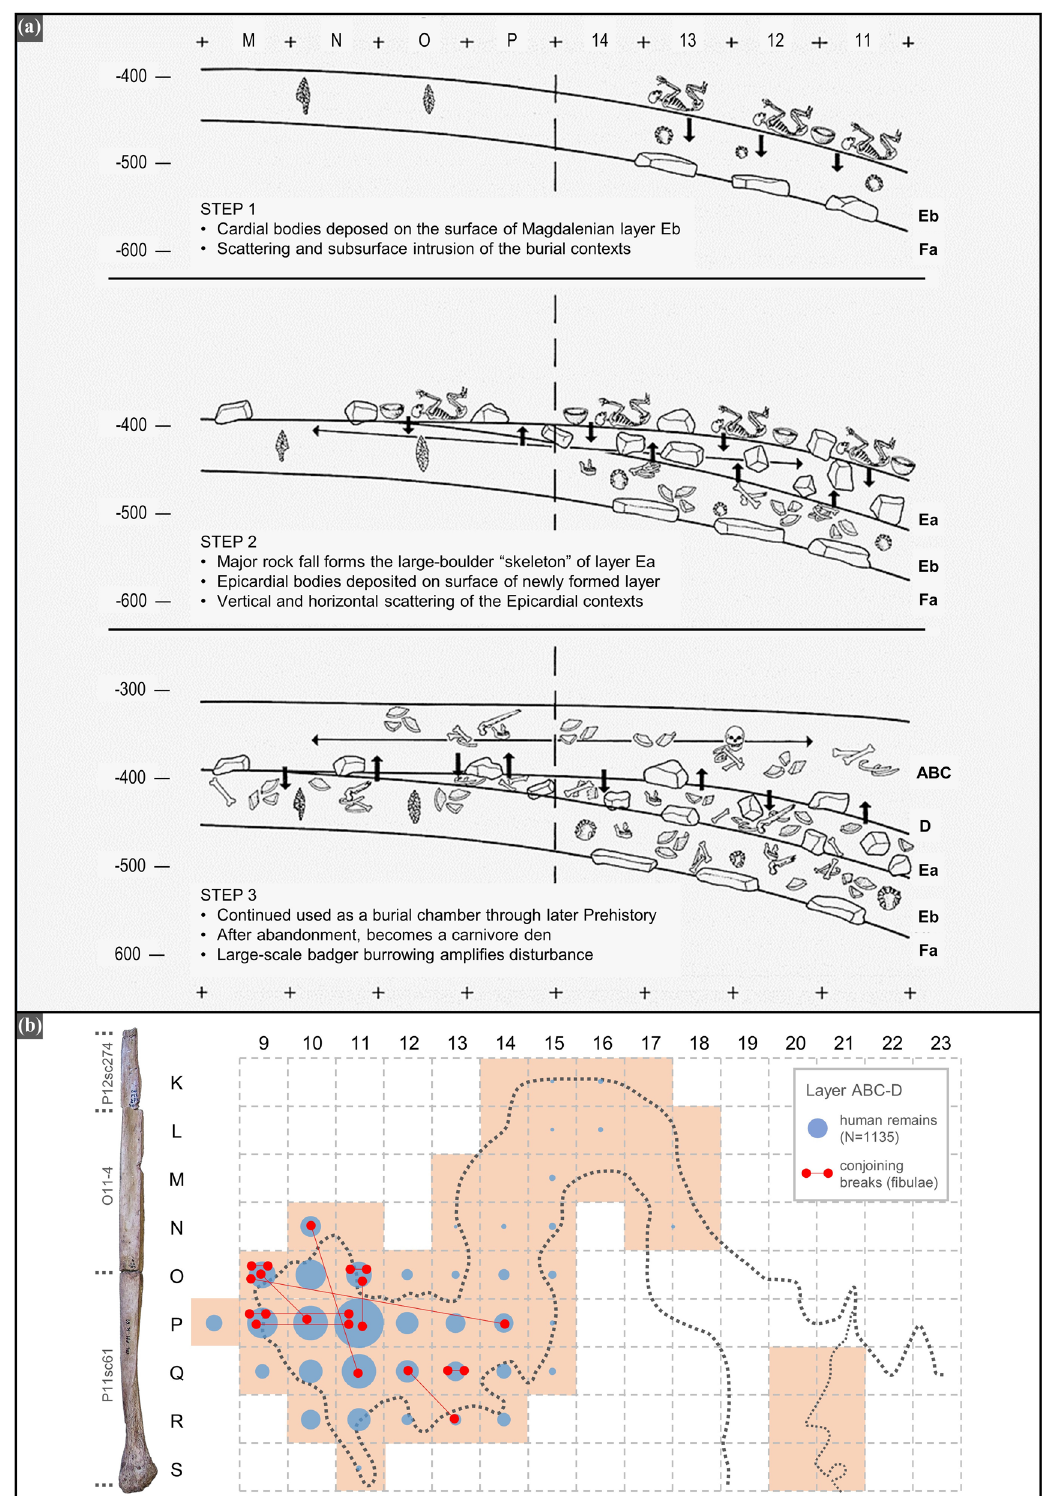
Figure 4: Gruta do Caldeirão. Excavation and stratigraphy. ( a ) Site formation process of the Holocene sequence inferred from stratigraphy, re fi tting and spatial distributions ( after Zilhão, 1992, Figure 3.11 ) . ( b ) Bubble plot of human osteological remains from layer ABC - D and links conjoining the broken human fi bulae therein